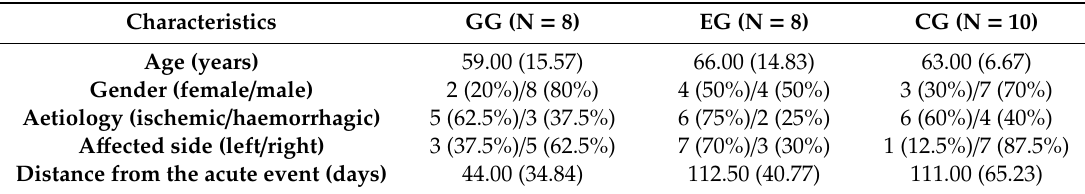
Table 1. Demographic and clinical characteristics of the